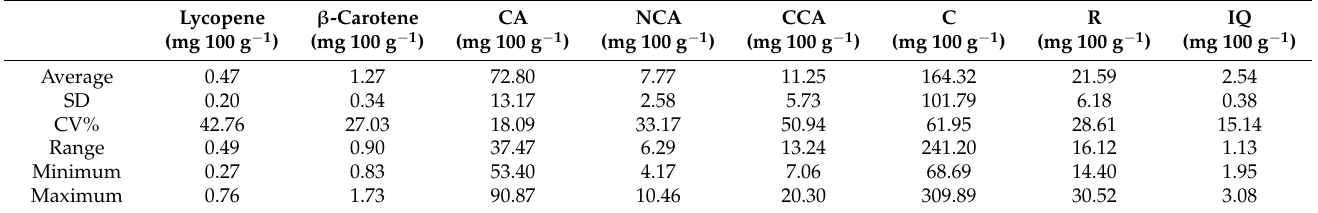
Table 5. Descriptive statistics of honeyberry lycopene, β -carotene, chlorogenic acid (CA),